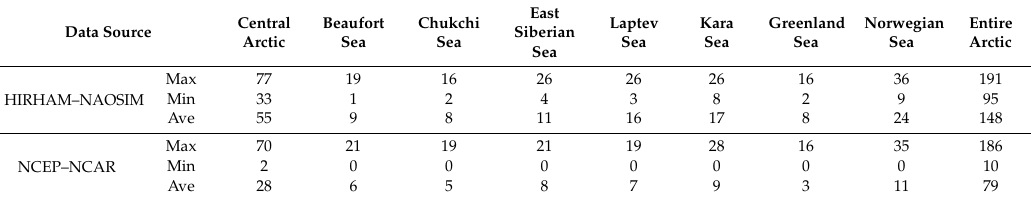
Table 1. The maximum, minimum, and climatological mean counts of summer (1 July–15 September) storms during 1948–2008 in HIRHAM–NAOSIM (the High Resolution Limited Area Model (HIRLAM) dynamics with the physical parameterizations from the Max Planck Institute for Meteorology version of ECMWF global numerical weather prediction model for the atmospheric component model HIRHAM, and coupled with the North Atlantic/Arctic Ocean-Sea Ice Model NAOSIM) simulations and National Centers for Environmental Prediction-National Center for Atmospheric Research (NCEP–NCAR) reanalysis.